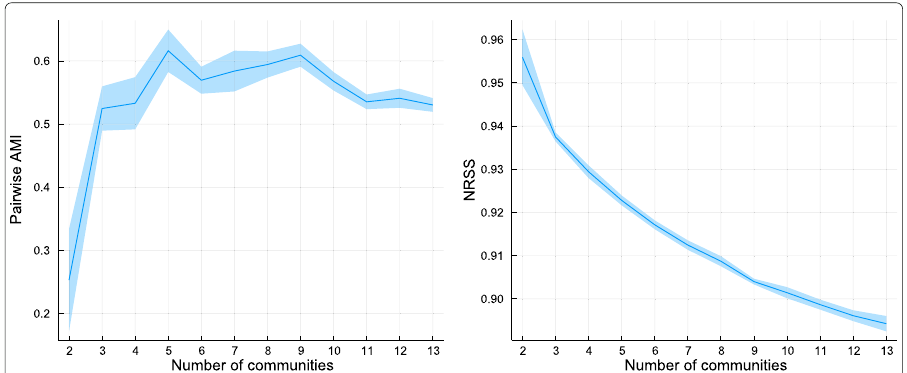
Fig. 18 Maven community activity. Relative activity of each community in each month. The communities are named by important packages as detailed in the “Methods”